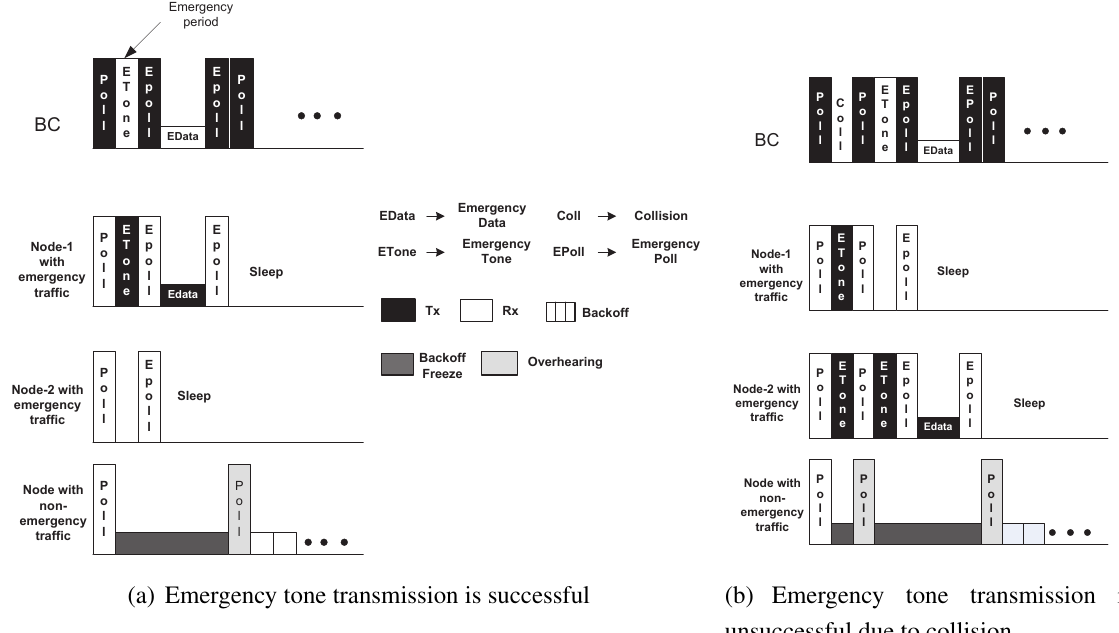
Figure 5. Emegency Packet handling during contention access